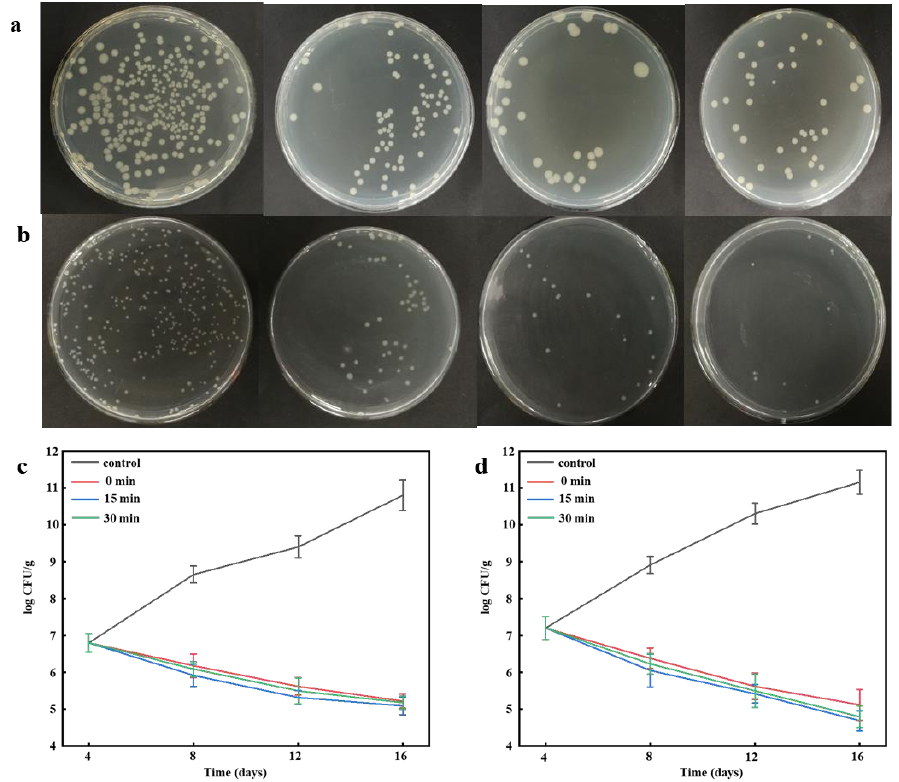
Figure 7. Effect of nanofibers on the growth of ( a ) E. coli and ( b ) S. aureus on TSA medium stored at 4 °C; Survival of ( c ) E. coli and ( d ) S. aureus in nanofibers under different ultrasound times throughout storage time at 4 °C for 16 days